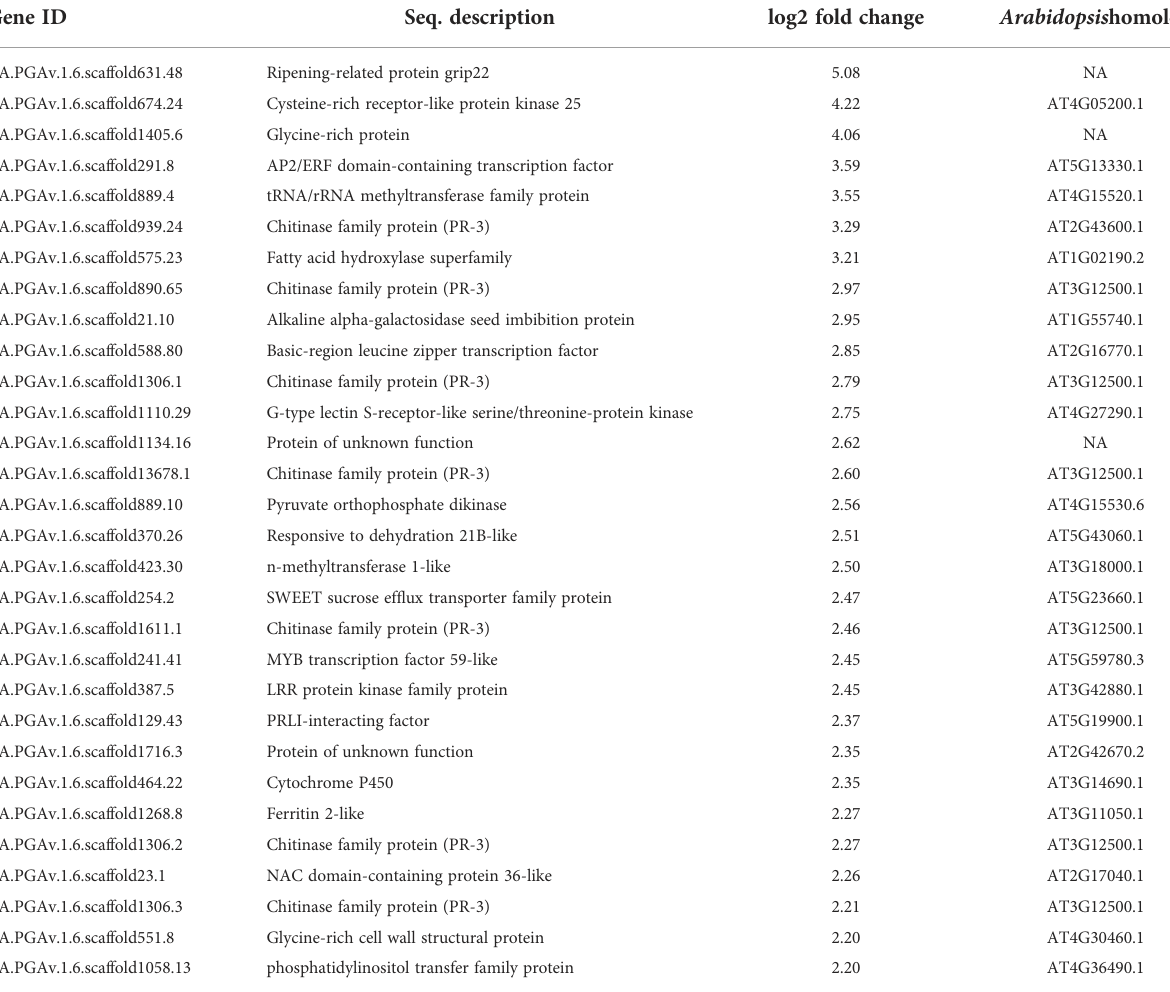
TABLE 1 Top 30 upregulated DEGs in response to infection with CMV. Gene